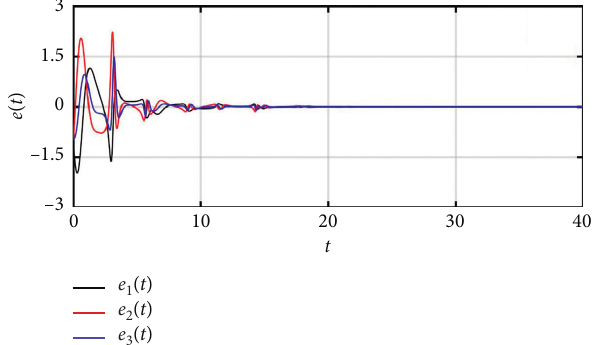
Figure 9: Variation of the difference e with R � 1.0 and C � 0.2.